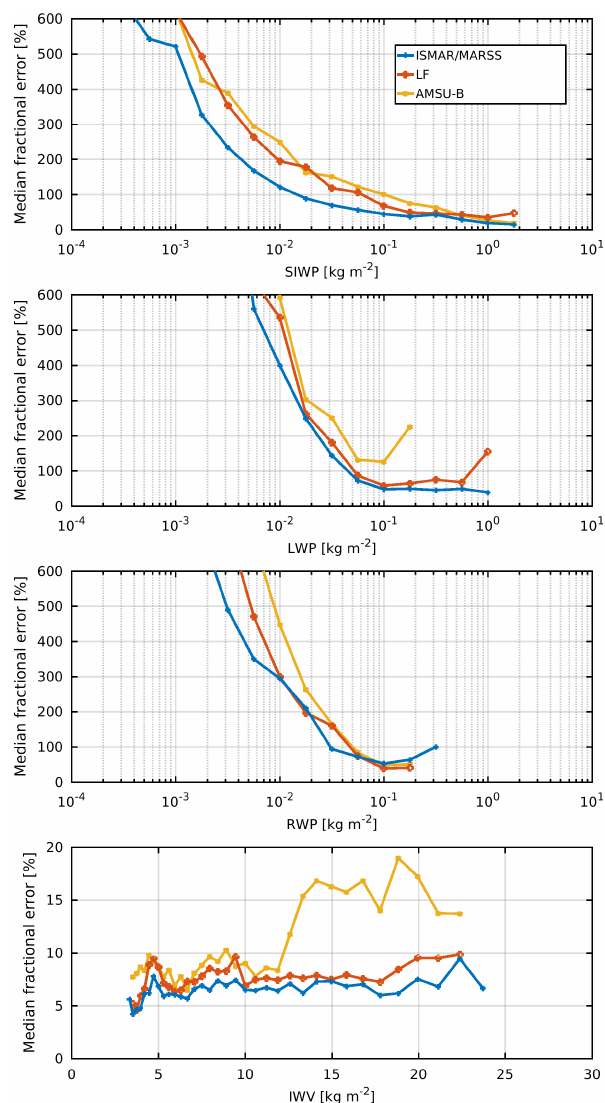
Figure 5. Median fractional error as function of the components of the retrieved state vectors. The blue lines indicate the MFE of the retrieval using all ISMAR and MARSS channels. The red lines indicate the MFE using all ISMAR and MARSS channels up to the 183GHz channels for the retrieval and the orange lines indicate the MFE using a AMSU-B type sensor. See Sect. 4.3 for details.